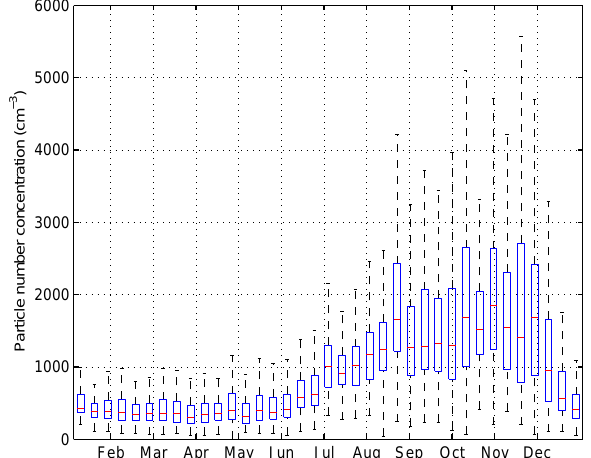
Figure 1. Statistics for a 10-day window for particle number con- centrations between 2008 and 2014. The dataset is a combination of particle number concentration measurements and integrated par- ticle size distribution measurements (10–600nm). The red line rep- resents the median, the extremes of the blue boxes represent the 25 and 75 percentiles and the black whiskers extend to the most ex- treme data points that are not considered